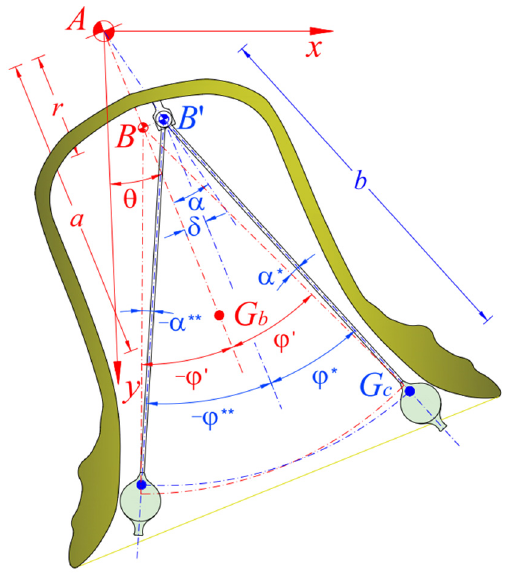
Figure 3. Swing intervals of the clapper.